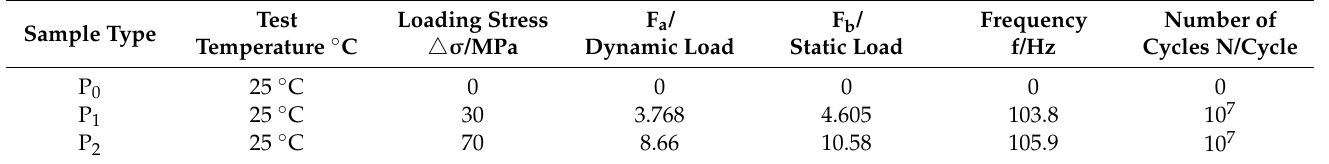
Table 1. Fatigue test parameters of A7N01P-T4 aluminum alloy base